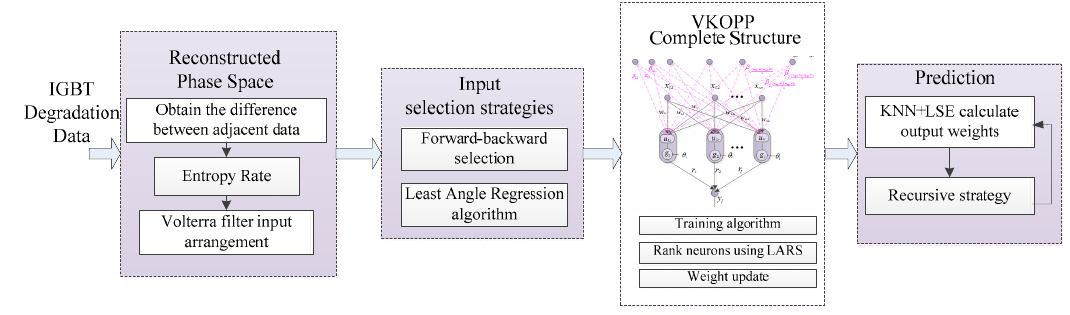
Figure 6. Prediction principles of the proposed VKOPP model.